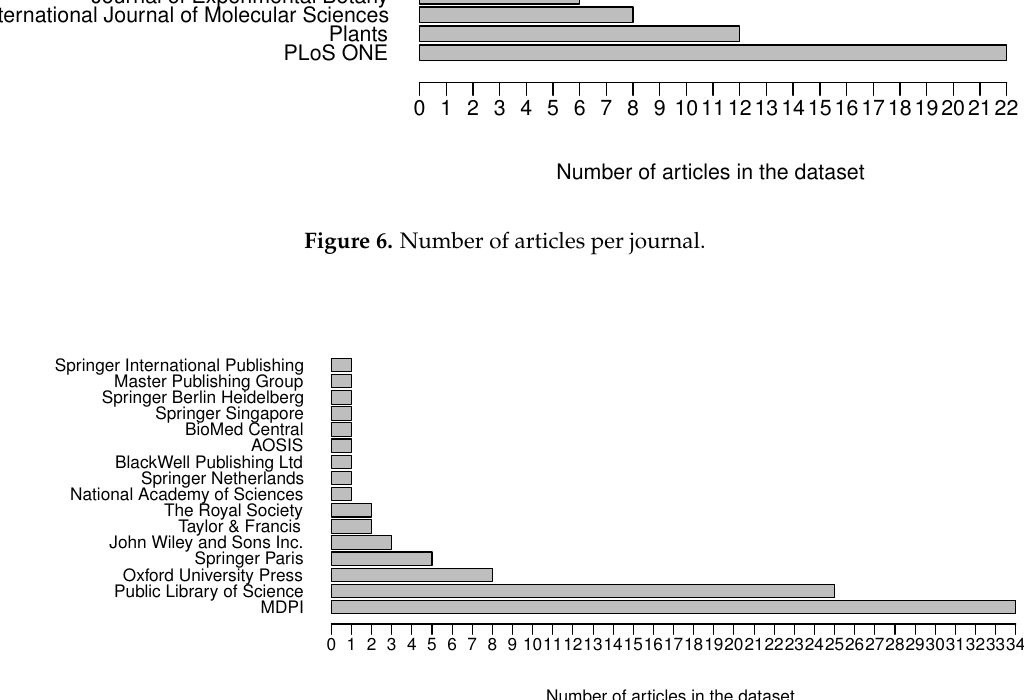
Figure 7. Number of articles per